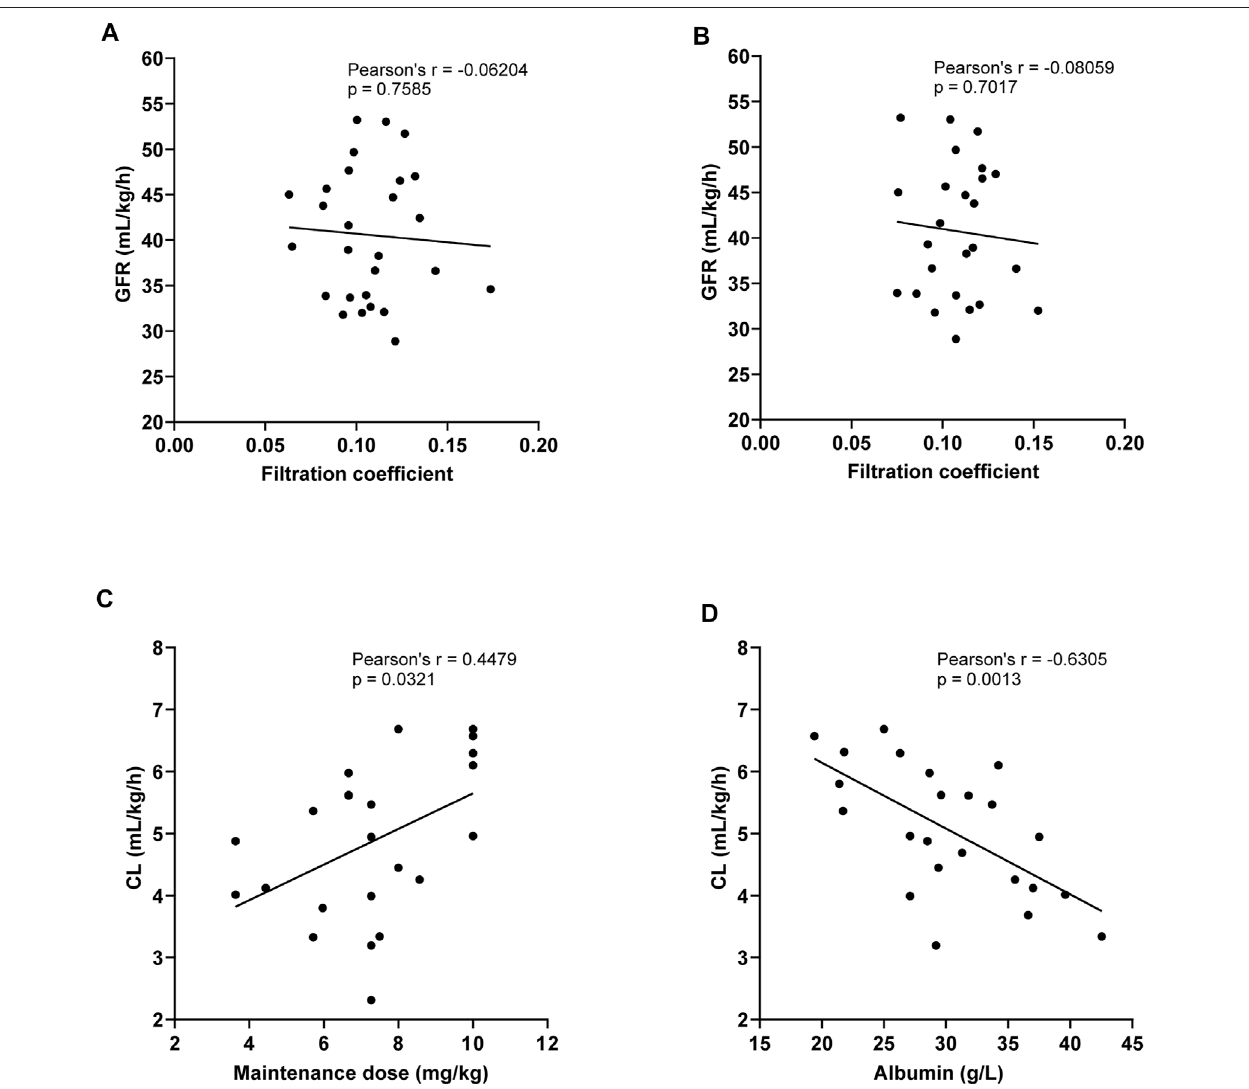
FIGURE 4 | (A,B) Linear regression analysis was used to compare the correlation between the GFR and fi ltration coef fi cient at the 6th – 8th dose of TEI C min (A) or C max (B) . The GFR had no correlation with the fi ltration coef fi cient (r = − 0.06204, p = 0.7585; r = − 0.08059, p = 0.7017). (C) The clearance of TEI in CRRT patients was positively correlated with the maintenance dose of TEI (r = − 0.4479, p = 0.0321). (D) The clearance of TEI in CRRT patients was negatively correlated with the albumin level (r = − 0.6305, p =